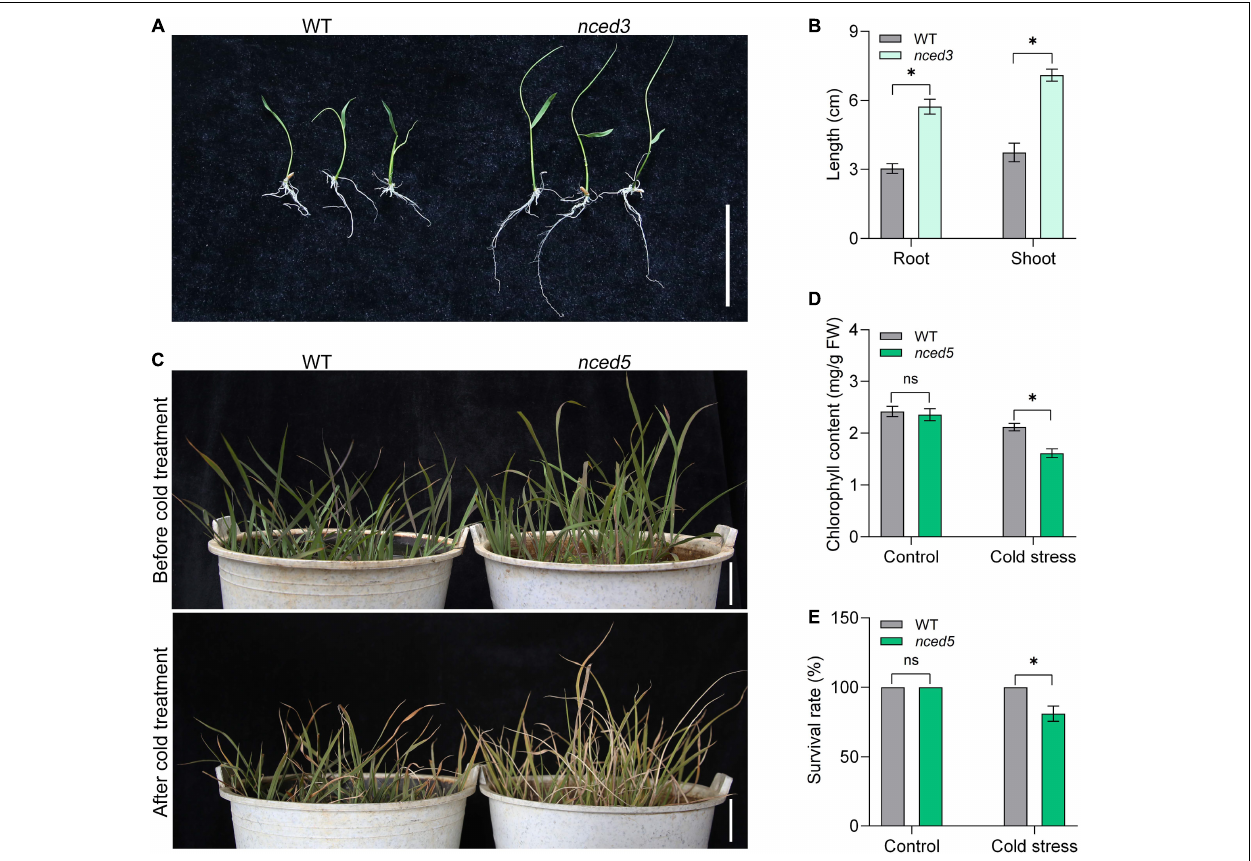
FIGURE 5 | Phenotype analysis of the genome-editing mutants of CLCWR. (A) Phenotype analysis of nced3 mutant. The seeds of wild type and mutant were soaked for 24 h after dormancy was eliminated. Then the seeds were transferred to 37 ◦ C incubator for germination for 7 days. Bar = 5 cm. (B) The length of root and shoot of wild type and mutant seedlings after germinating for 7 days. (C) Phenotype analysis of nced5 mutant. Wild type and nced5 mutant seedlings were cultured in the soil until the four-leaf stage. Then the seedlings were treated at 4–6 ◦ C for 3 days and then recovered for 7 days. Bars = 5 cm. (D) Chlorophyll content of wild type and nced5 mutant after cold treatment. (E) Survival rate of wild type and nced5 mutant after cold treatment. Significant differences were found between cold stress and control conditions (* P < 0.01 by Student’s t -test). Data are means of three replicates of one experiment. The experiment was repeated three times with similar results. Error bars represent ± SD. *, significant; ns, not